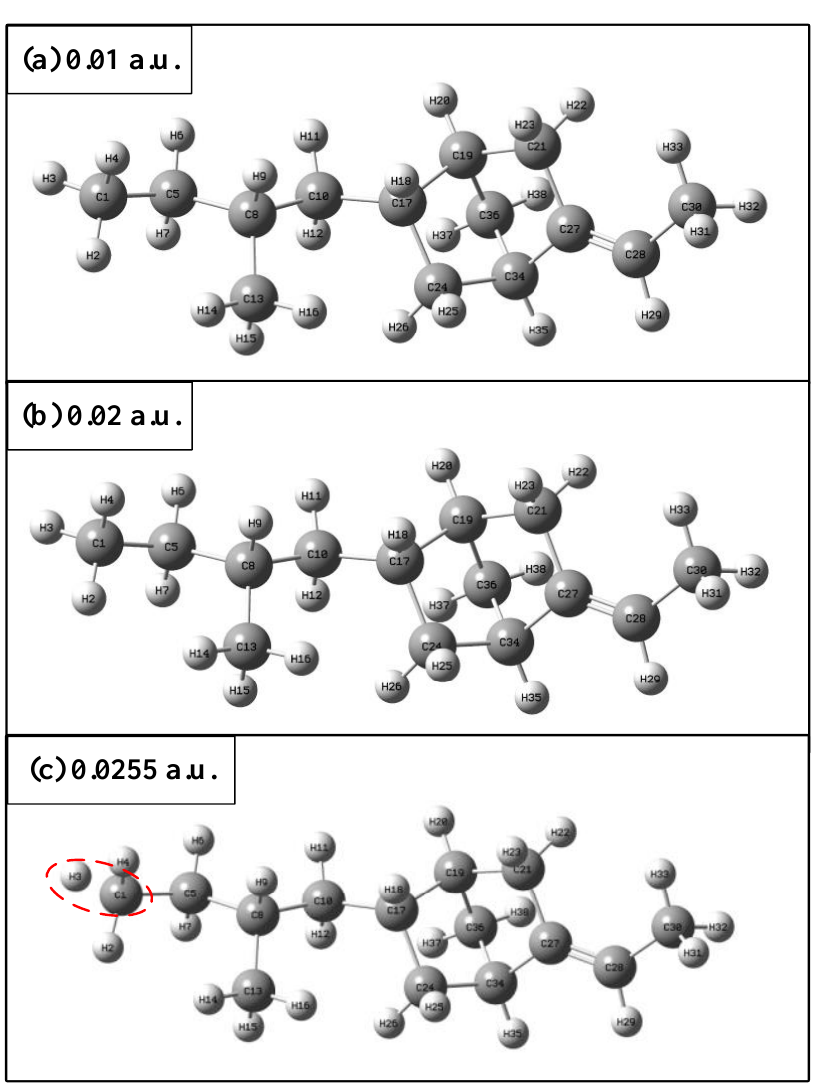
Figure 5. ENB-EPDM molecule at different external electric fields.